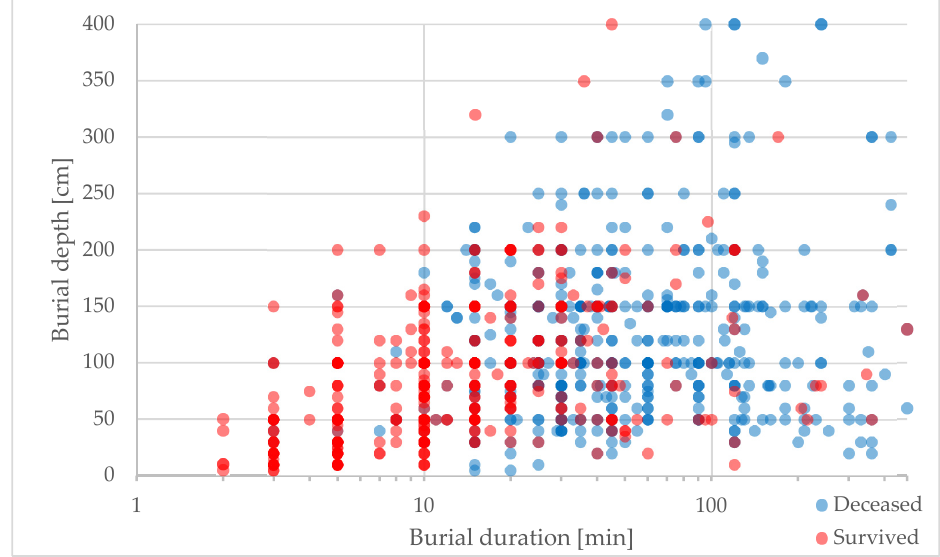
Figure 4. Survival chances based on burial duration and burial depth (N = 1070). The saturation of red for survived and blue for deceased cases increases with the increase in number of cases. For datapoints including survived and deceased cases, the gradually changing shading between red and blue is used to visualize the distribution of survived and deceased cases.